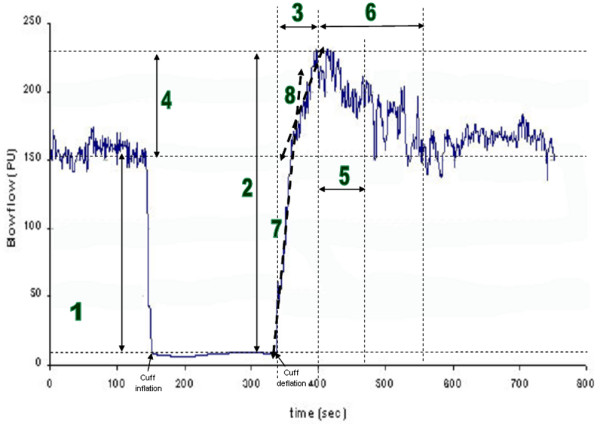
Example of a laser Doppler recording of blood flow during reactive hyperaemia in a patient sedated with midazolam. 1: Mean blood flow at rest (Φrest). 2: Peak flow (Φpeak). 3: Time to peak. 4: ΔΦ = Φpeak - Φrest. 5: Time to flow normalisation. 6: Time to half flow normalisation. 7: First upward slope calculated for the first three seconds. 8: Second upward slope calculated for the second half. PU, perfusion units.